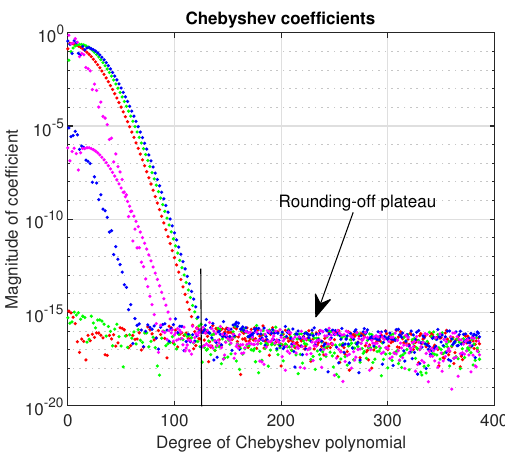
Figure 3. In a log-linear plot, the Chebyshev coefficients of the first four eigenvectors of the Coffey- Evans problem computed by